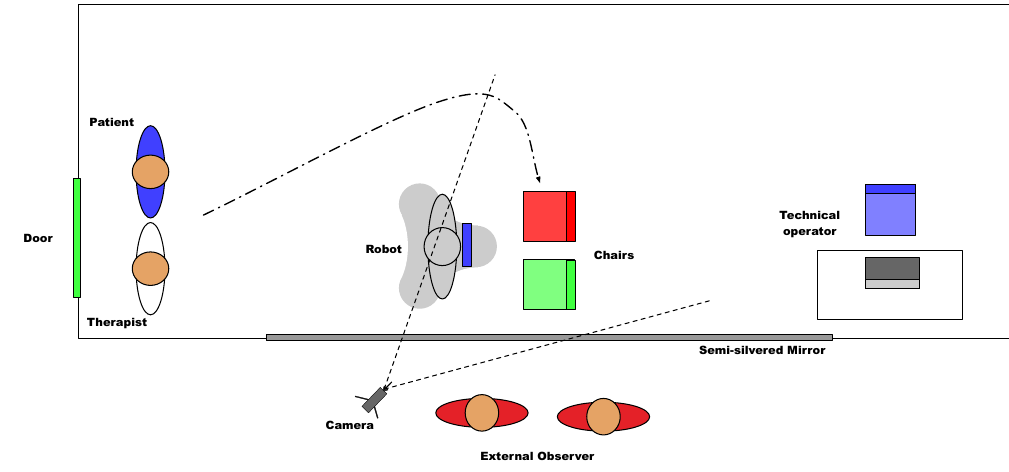
Figure 4. Scheme of the scenario of the experiment.